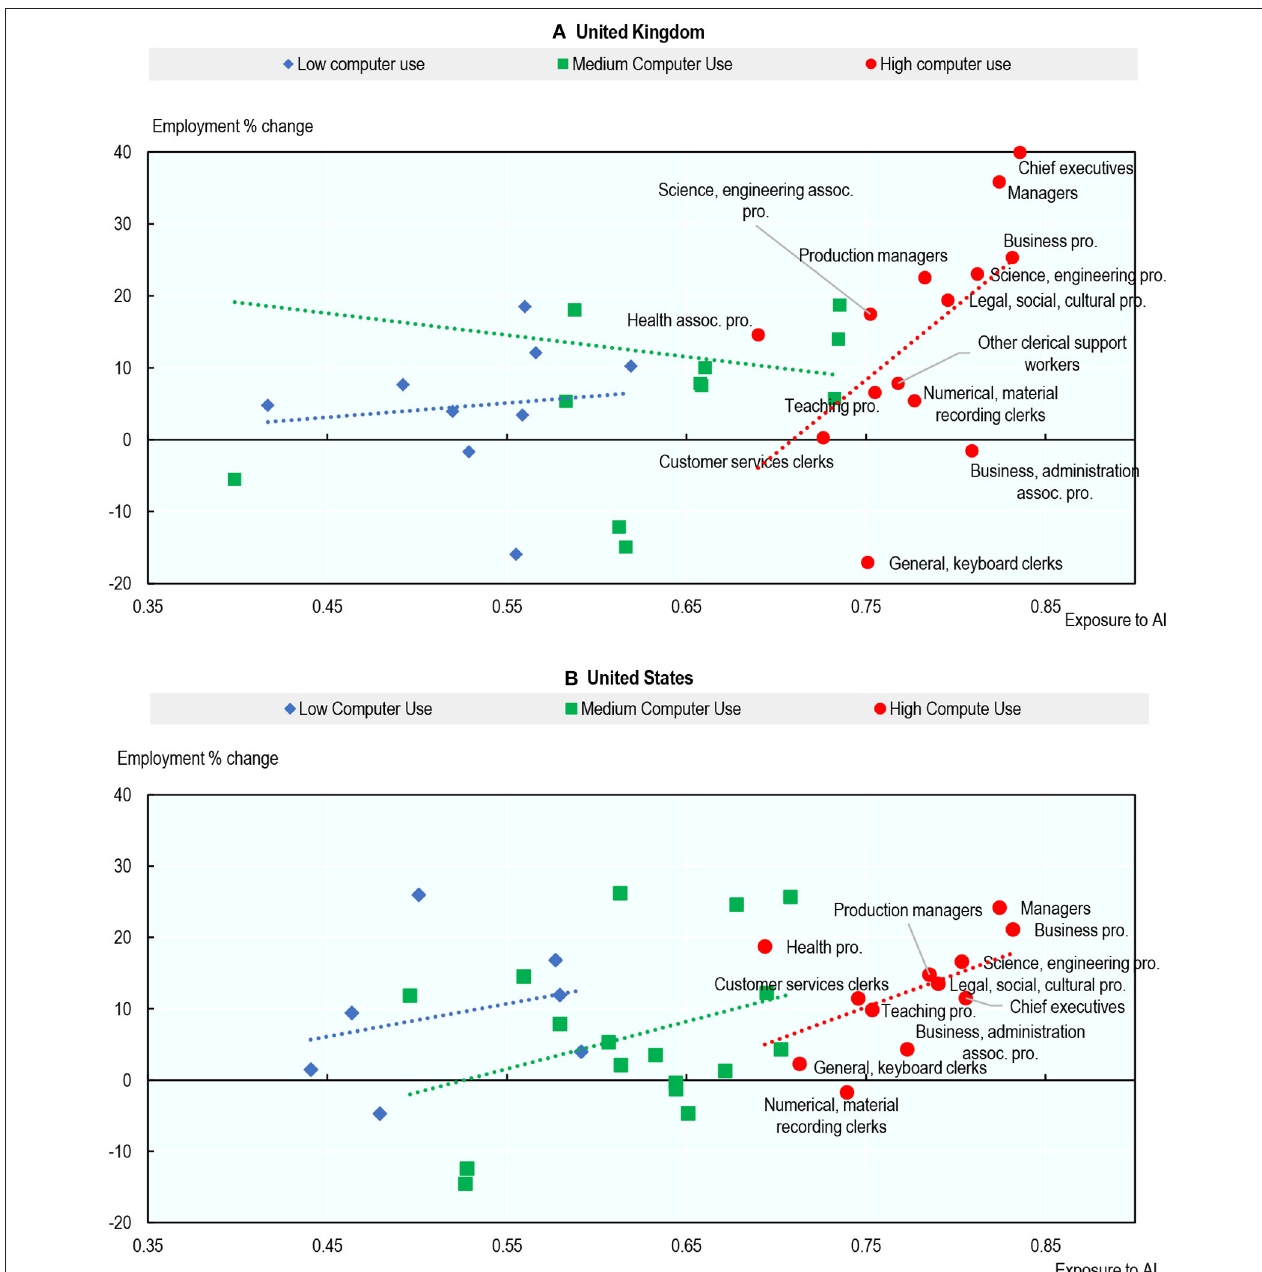
FIGURE 13 | Exposure to AI is associated with higher employment growth in occupations where computer use is high. Percentage change in employment level (2012–2019) and exposure to AI (2012). Occupations are classified using two-digit ISCO-08. Not all occupations have marker labels due to space constraints. Skilled forestry, fishery, hunting workers excluded from (A) for readability reasons. Occupation-country cells are classified into low, medium or high computer use by tercile of computer use applied across the full sample of occupation-country cells. Source: Authors’ calculations using data from EU-LFS, US-CPS, PIAAC, and Felten et al. (2019). (A) United Kingdom and (B) United